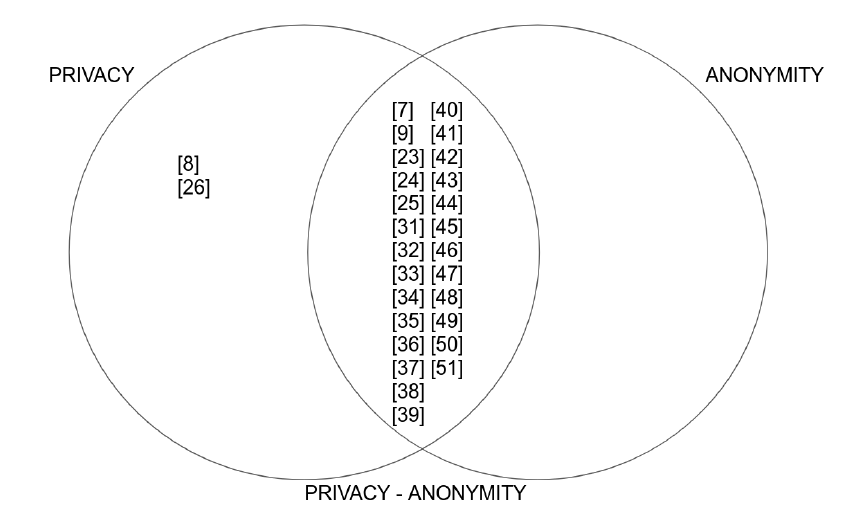
Figure 3. Relationship between the terms analysed in the different